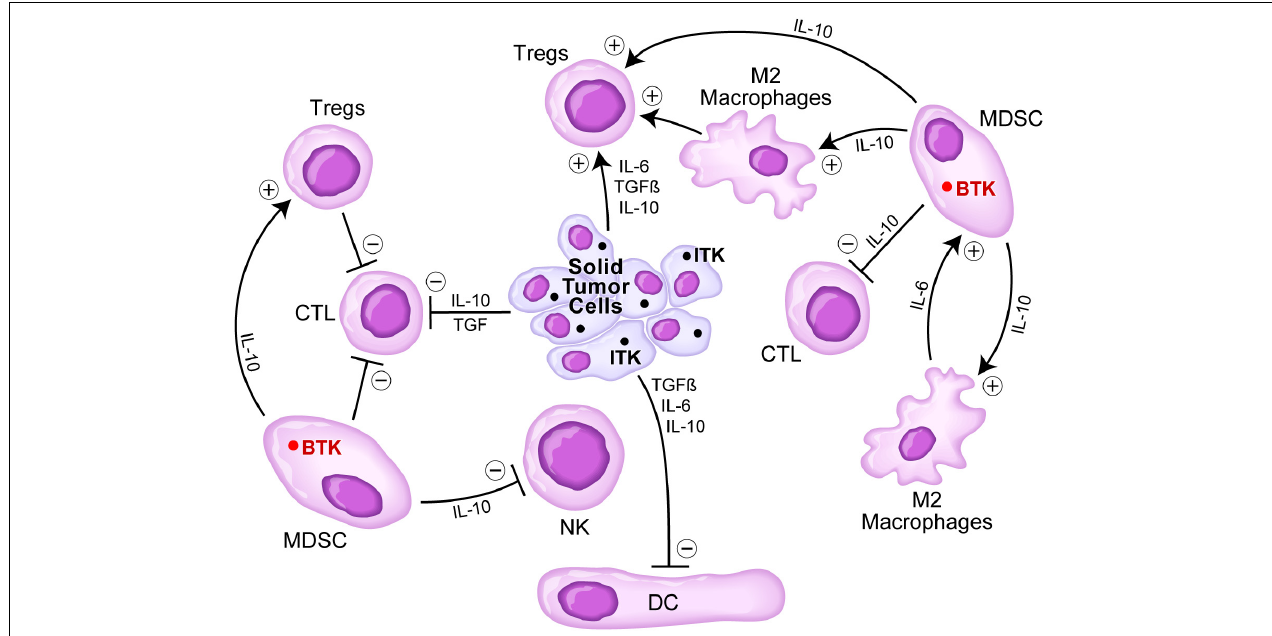
FIGURE 2 | Immunosuppressive TME in solid tumors. Tumor cells secrete several cytokines including IL-6, TGF β , and IL-10 that inhibit DCs, CTLs, but stimulate regulatory T cells (Tregs). Myeloid-derived suppressor cells (MDSCs) are stimulated via IL-6 by M2 macrophages and stimulate M2 macrophages as well as Tregs via IL-10, but they inhibit via IL10 CTLs and NK cells. Since solid tumor cells express the TEC kinase inducible T-cell kinase (ITK) related to BTK and MDSCs express BTK, BTK inhibition might offer an effective strategy to overcome an immunosuppressive TME. See text for a detailed